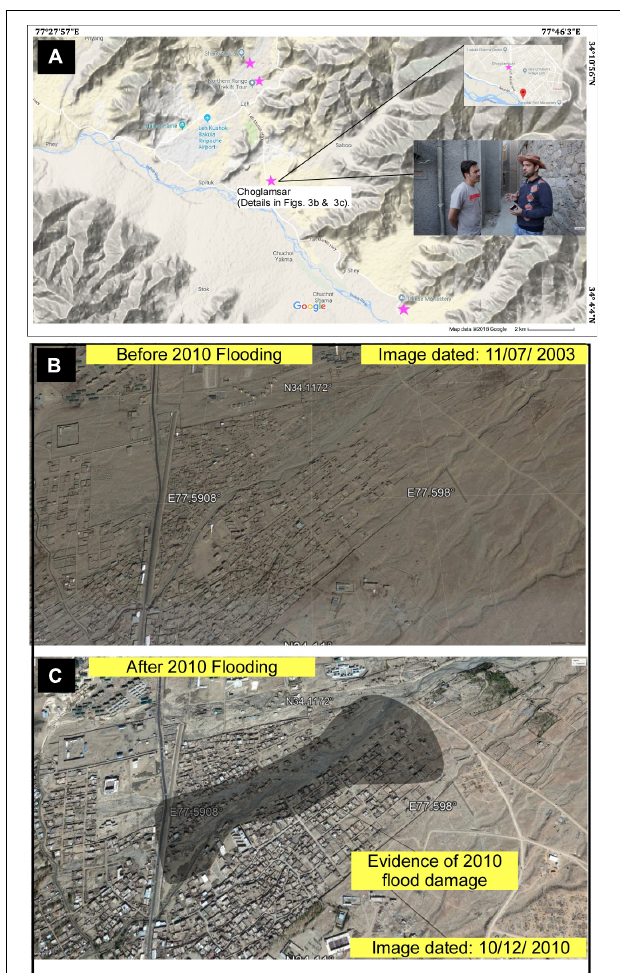
FIGURE 3 | The Google terrain image (A) shows the location of Choglamsar area that was badly impacted by the 2010 flooding. (B) The Google satellite image before 2010 flood and panel (C) is the image after the 2010 flooding. The extent of devastation is visible (highlights in polygon). The first figure (A) is obtained from Google maps on 20th July 2018, and subsequent figures (B,C) are also acquired on the same date from Google Earth that uses images from Digital